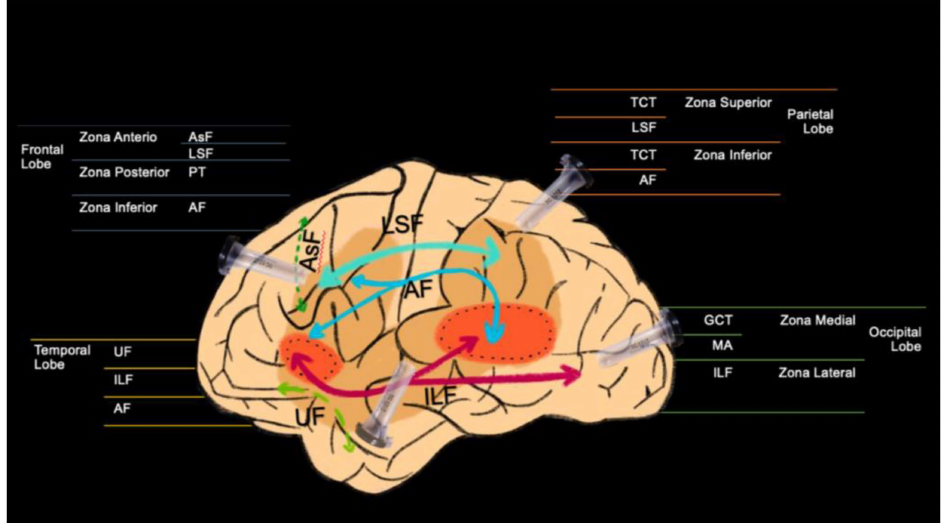
Figure 7. Fiber tracts usually reconstruct in our practice during preoperative planning. AsF: Aslant fasciculus; LSF: Superior Longitudinal fasciculus; PT: Pyramidal tract; AF: Arcuate fasciculus; UF: Uncinate fasciculus; ILF: Inferior longitudinal fasciculus; TCT: Thalamic cortical tract; GCT: Geniculo- calcarine tract; MA: Meyer’s